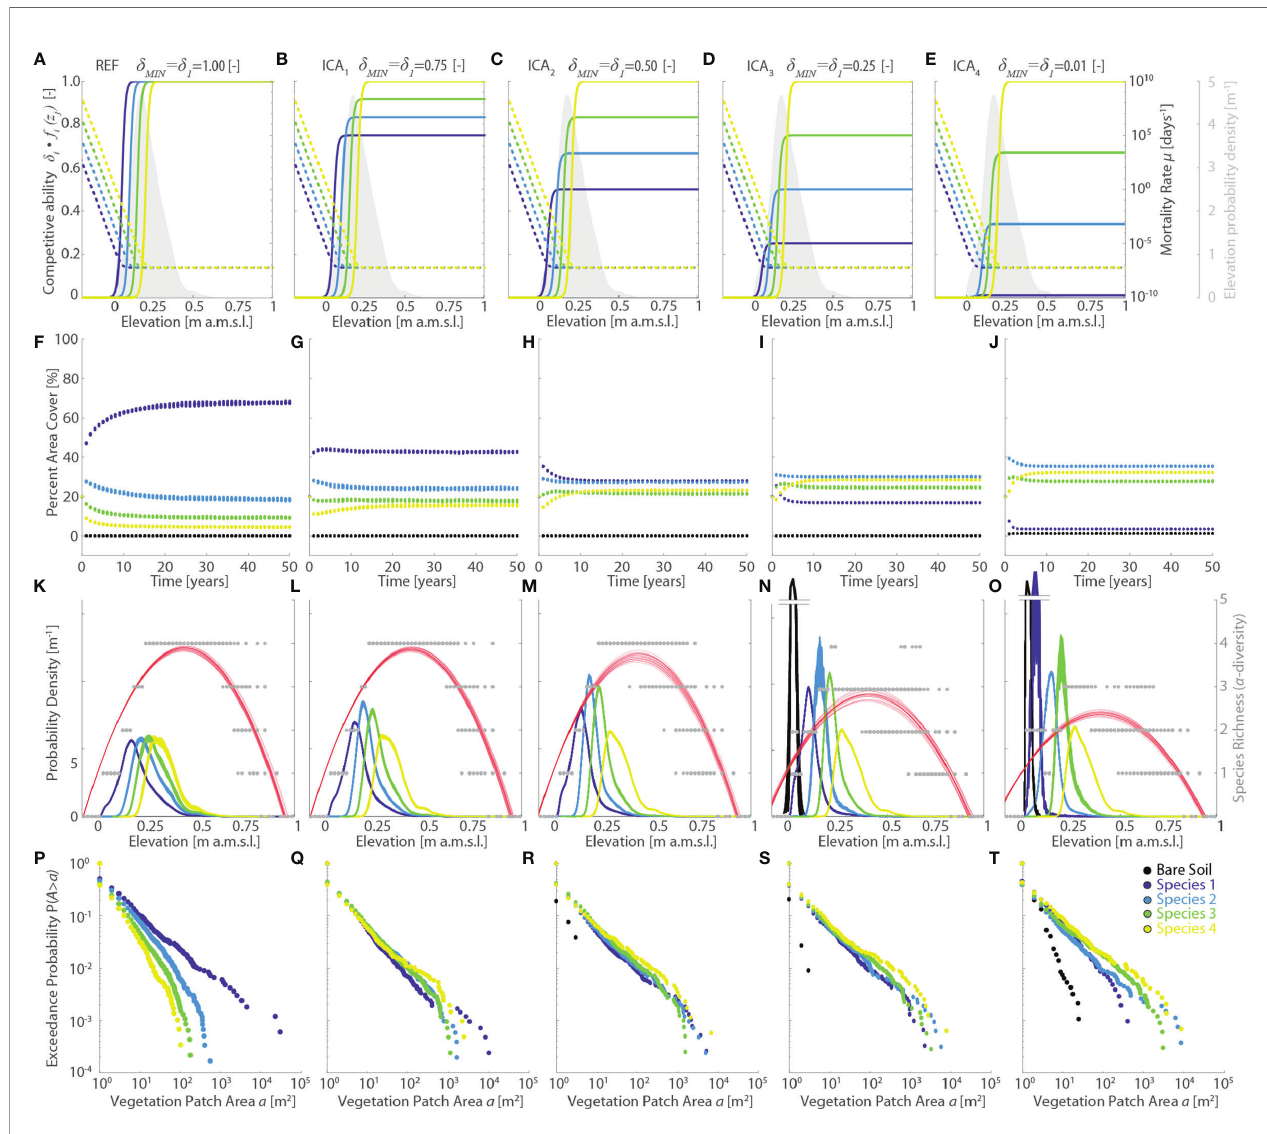
FIGURE 6 | Effects of changes in the vegetation interspeci fi c competitive ability (ICA series, varying d 1 = d MIN ). Results of the reference simulation (REF, d MIN = 1) are shown in the fi rst column. Columns from second to fourth show results of the ICA 1 ( d MIN = 0.75), ICA 2 ( d MIN =0.50), ICA 3 ( d MIN =0.25), and ICA 4 ( d MIN =0.01) simulations, respectively. Each panel displays data derived from all the 20 numerical simulations performed for each scenario. Different colors denote different vegetation species, including bare soil, according to the legend shown in the lower-right panel. (A – E) Patterns of speci fi c competitive ability d i f i ( z j ) (continuous lines, left y-axis) and mortality rate µ i ( z j ) (dotted lines, right y-axis) as a function of local marsh elevation ( z j ).The gray area denotes the probability density estimates of marsh elevation within the computational domain. (F – J) Changes of percent vegetation cover over the whole simulation horizon. (K – O) Realized vegetation niches (left y- axis) and local species richness (i.e., a -diversity, right y-axis) as a function of marsh elevation at the end of the simulation horizon. Gray dots represent a -diversity point data with red lines showing the best quadratic fi t to point data. (P – T) Empirical probability distributions of spatially-continuous vegetation patch areas are shown based on the exceedance probability for a given vegetation patch